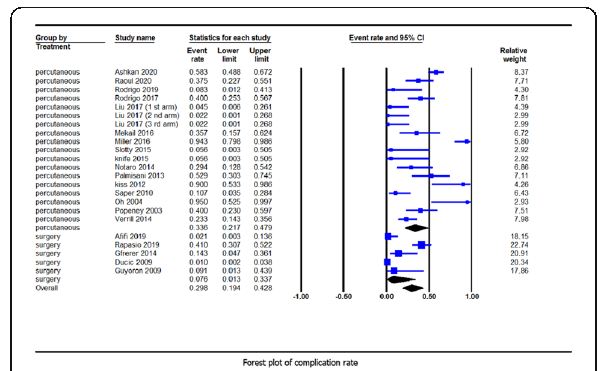
Fig. 2 (abstract P0487). See text for